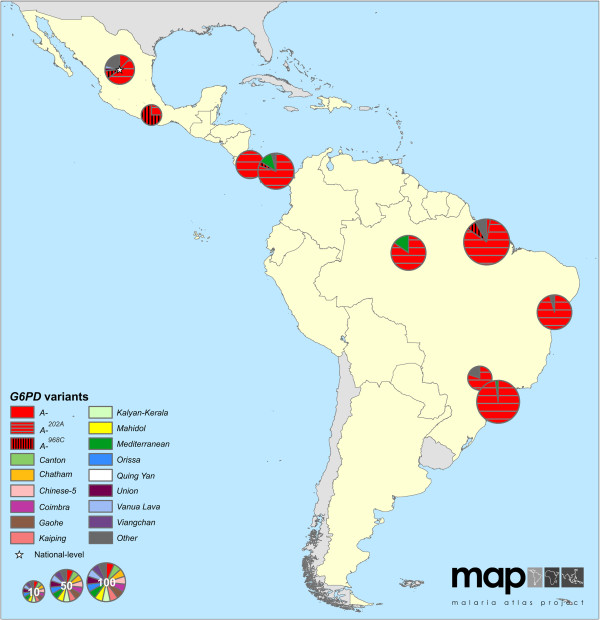
G6PDd variant proportion map: Americas (map series 1). Map includes nine surveys with a mean sample size of 71 (range: 8-196); one survey was mapped at the national level. Pie charts represent individuals previously identified as G6PDd. Sample size is reflected in the size of the pie charts, which is transformed for clarity on a square-root scale. Surveys which could only be mapped to the country-level are indicated by a white star; this applied to seven surveys globally. Spatial duplicates from independent studies were mapped with a “jitter” of 0.5-1 decimal degrees in their latitude or longitude coordinates to allow visualization of the multiple charts. Malaria-endemic countries in the region mapped are shown with a yellow background; white backgrounds indicate endemic countries outside the region in focus; grey backgrounds represent malaria-free countries. G6PDd variants that could not be diagnosed were reported as “Other”.